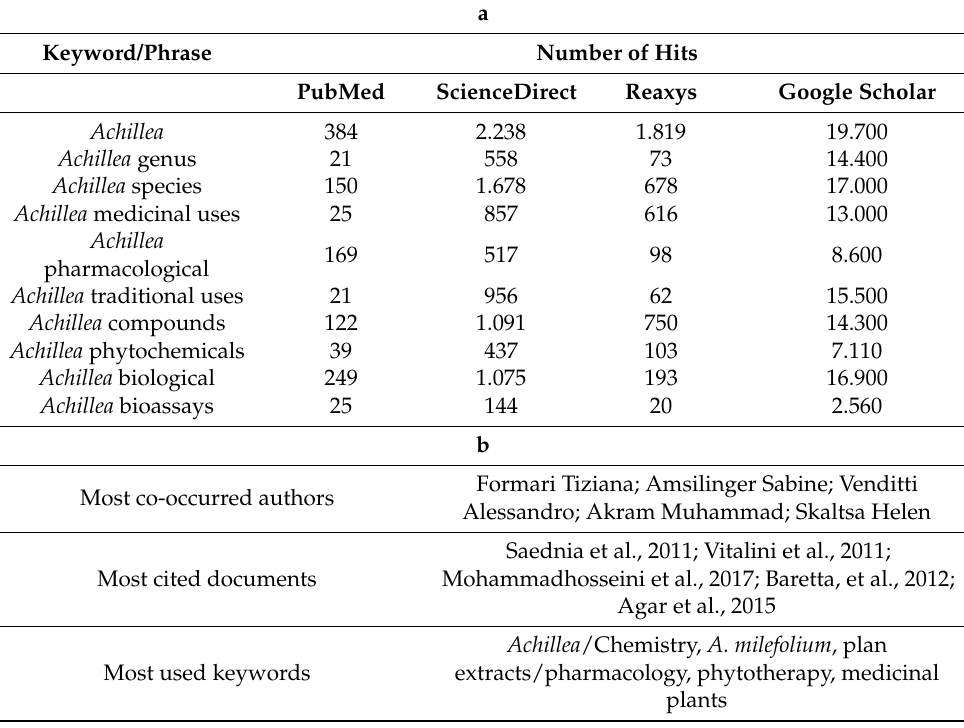
Table 1. ( a ) Bibliometric results of keyword/phrase search for genus Achillea . ( b ) Bibliometric results of the top 5: co-occurring authors, cited documents and